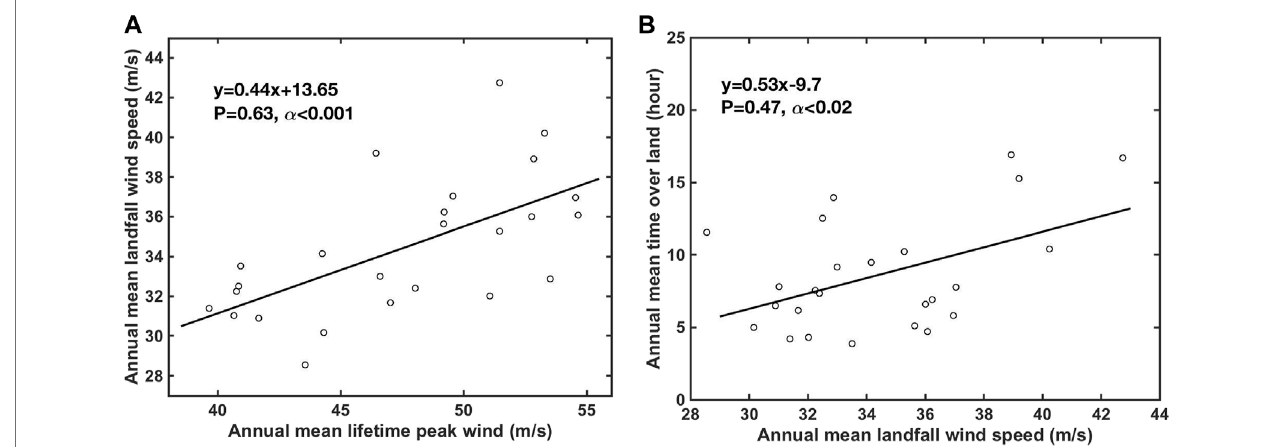
FIGURE 7 | MRI-AGCM3.2s simulated relationships in (A) between TC annual lifetime peak intensity and the landfall wind speed and (B) between the TC annual landfall wind speed and time duration over the land.